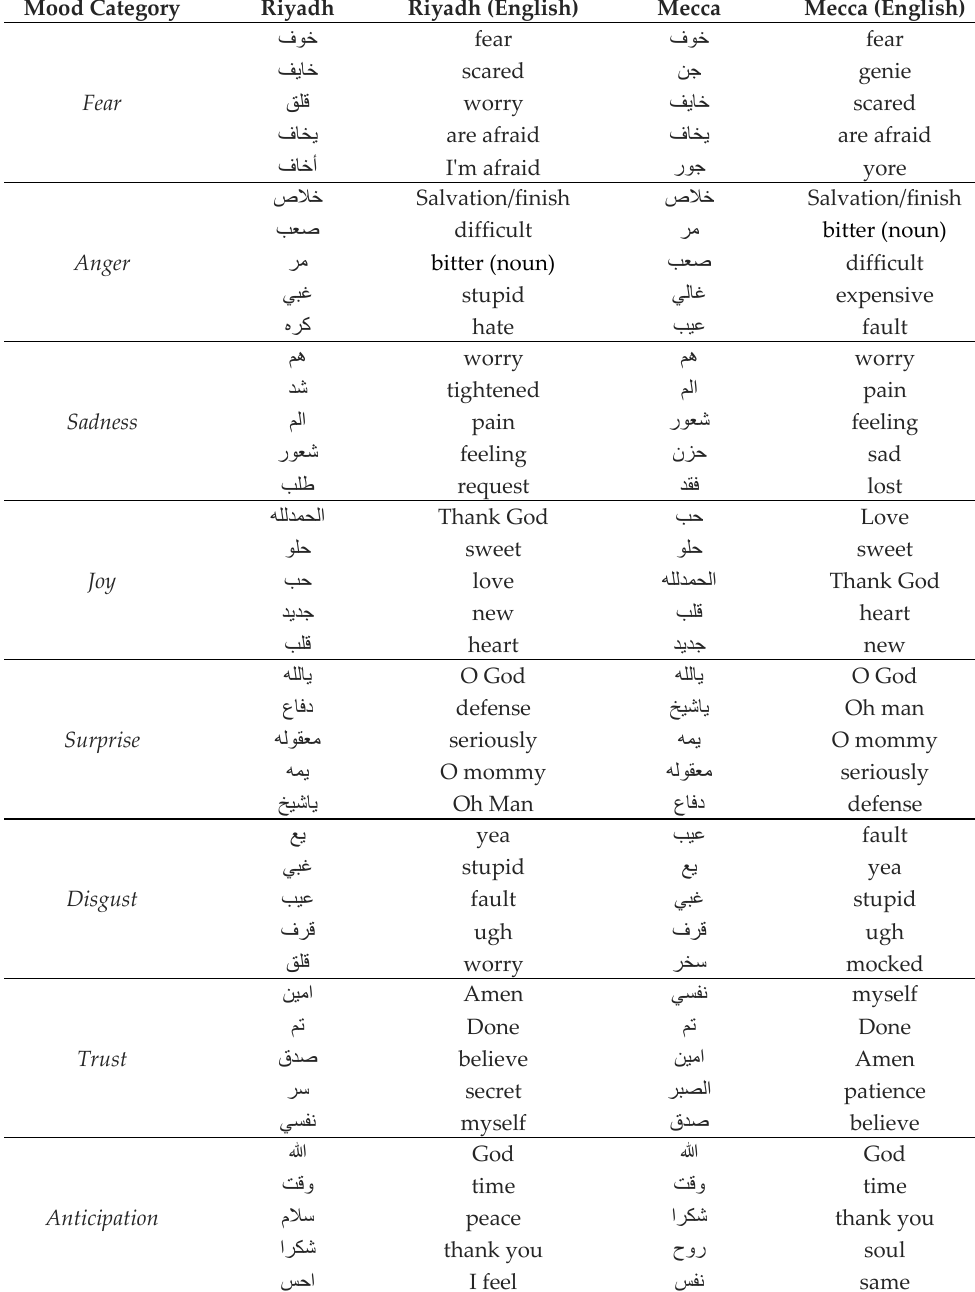
Table 7. Top 5 words from each emotion category.